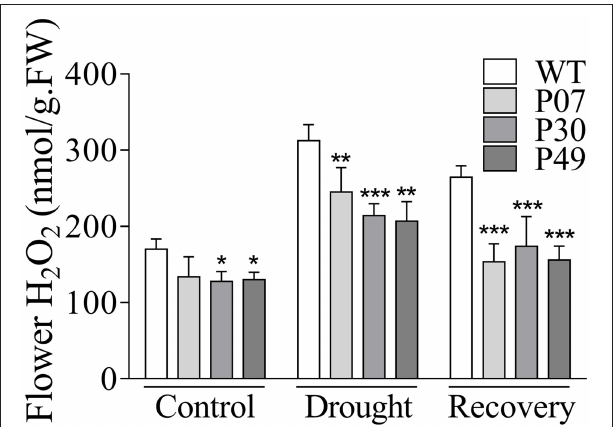
FIGURE 8 | Quantification of H 2 O 2 in flower buds of WT and AtUCP1 transgenic tobacco plants. Flower buds (8–12mm) were collected from WT and transgenic plants under control ( D = 0), drought stress ( D = 15), and recovery ( D = 16) conditions. Bars represent the means of 5 plants ± SD. Bars with *, **, and *** differ significantly from the WT ( P < 0.1, P < 0.05, and P < 0.01,